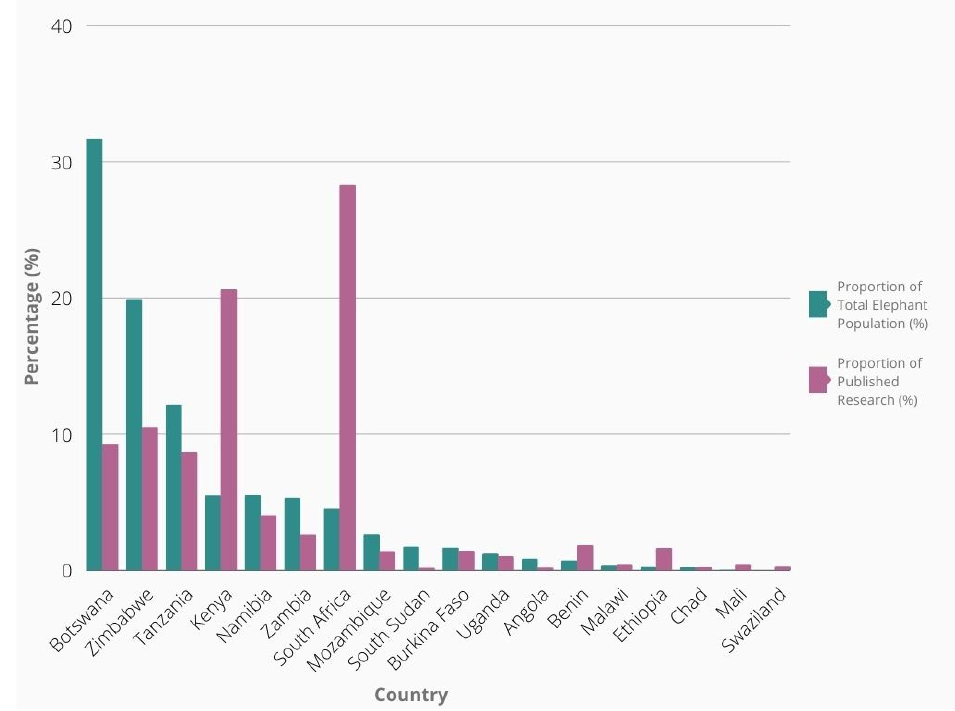
Figure 1. Research and populations by